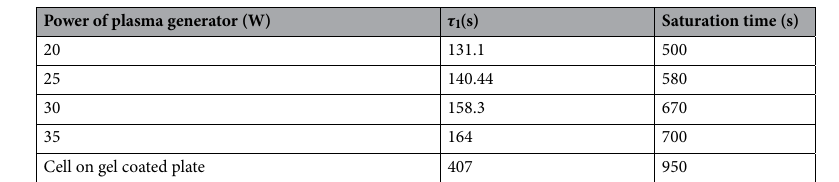
Table 1. The time constant and saturation time of cell exposed plasma with different generator powers, with:“Exposure Time: 60 s, Gas Flow Rate: 1 slm, and Distance between plasma plumes tip and cell: 5 mm”. As findings imply, the time constant and saturation time increased with increasing plasma power. For comparison, both time constant and saturation time of a cell on a gel-coated plate are also listed in the last row.